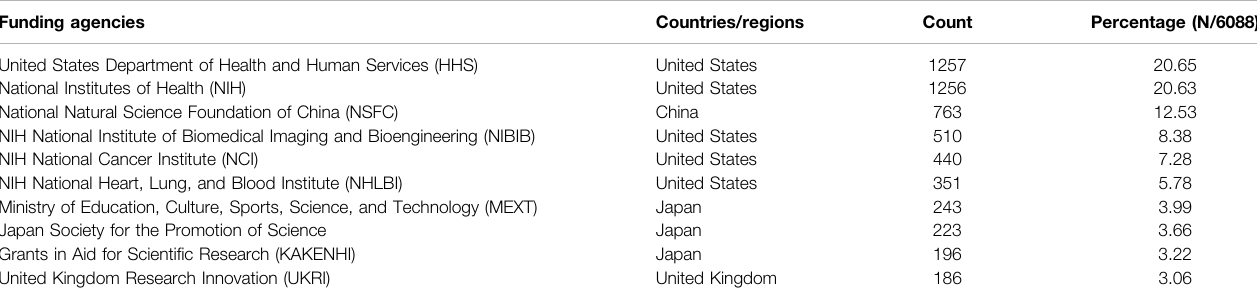
TABLE 2 | Top 10 related funding agencies.